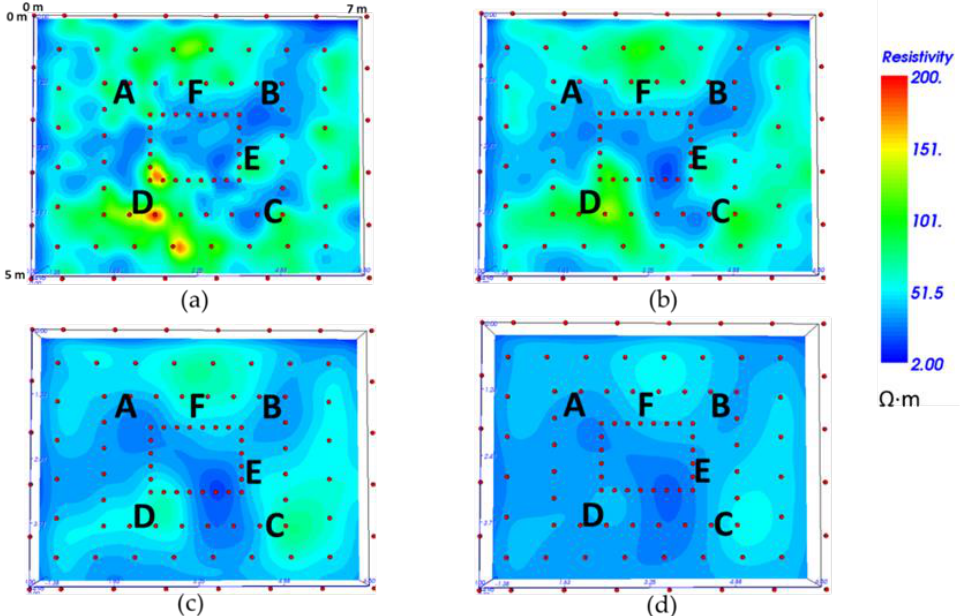
Figure 11. 3D loop–loop ERT depth-slices at 0.25 m ( a ), 0.45 m ( b ), 0.70 m ( c ), and 1.00 m ( d ) in WL2.